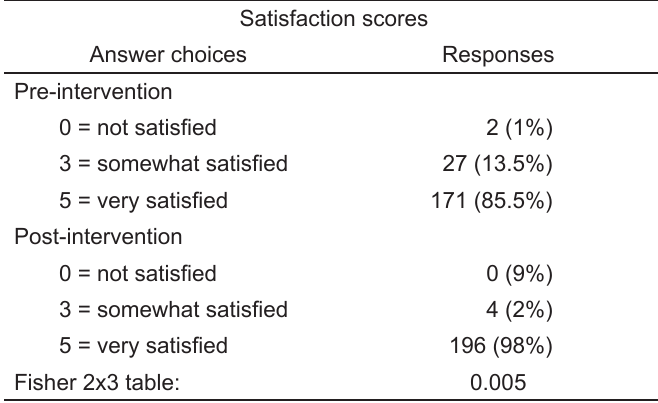
Fisher 2x3 table: 0.005 Differences between pre and post-intervention were analyzed with Fisher’s 2 x 3 variant test. P-values ≤0.05 were considered as statistically significant.